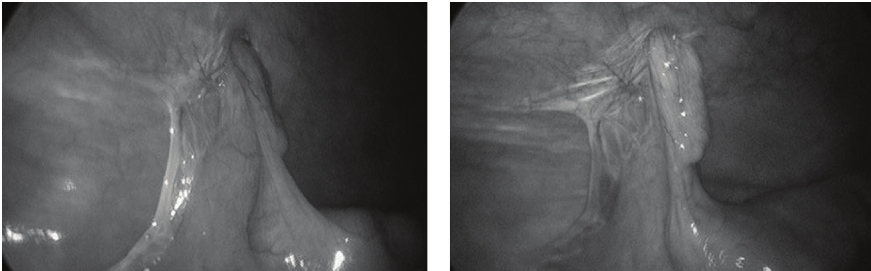
Figure 2: Intraoperative images demonstrating trocar site hernia containing the